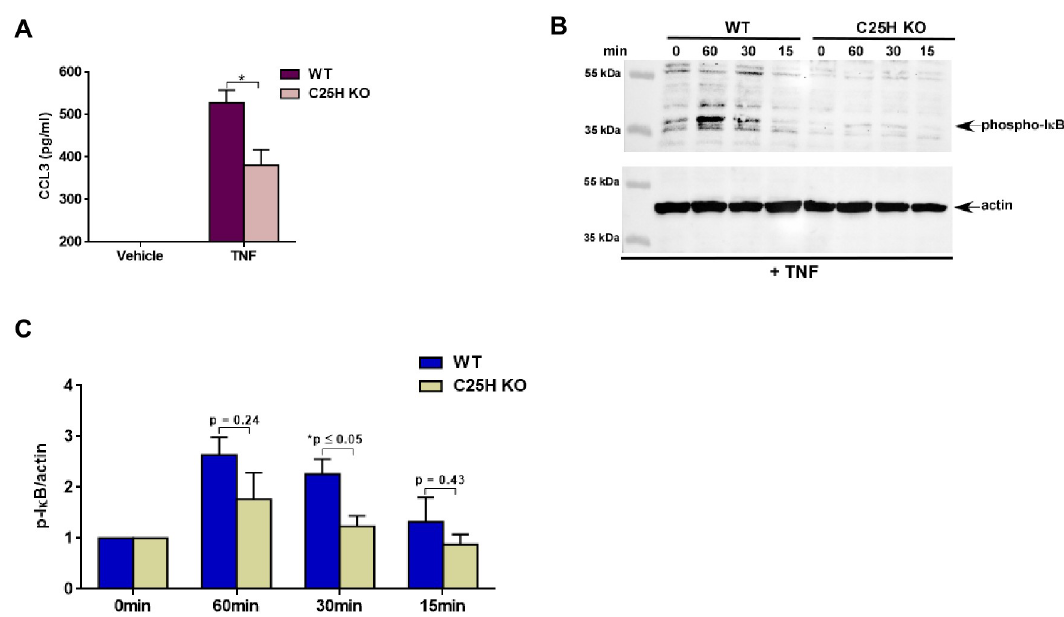
Fig 2. 25HC is required for optimal TNF mediated pro-inflammatory response and NF κ B activation. (A) Medium supernatant collected from WT and C25H KO BMDMs treated with TNF (100ng/ml) for 16h was analyzed for CCL3 production by ELISA (n = 12; three independent experiments). (B) Cell lysate collected from WT and C25H KO cells treated with TNF (100ng/ml) for 0–60 minutes were subjected to western blot analysis to detect status of phosphorylated I κ B (phospho-I κ B). The immunoblot is representative of three independent experiments with similar results. (C) Densitometric analysis of the western blot presented in Fig 2b. The densitometric quantification values for phospho-I κ B immunoblot represent the ratio of phospho-I κ B:actin and the fold- induction was calculated after normalizing with the control 0 min group. ELISA data are shown as Mean ± SEM. � p � 0.05 using a Student’s t-test. The densitometric values represent the mean ± SEM from three independent experiments. The p value shown in the figure was calculated using a Student’s t-test ( � p �